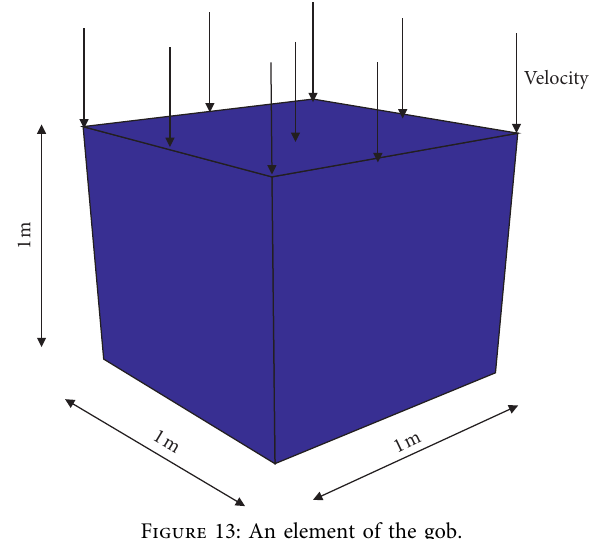
Figure 13: An element of the gob.